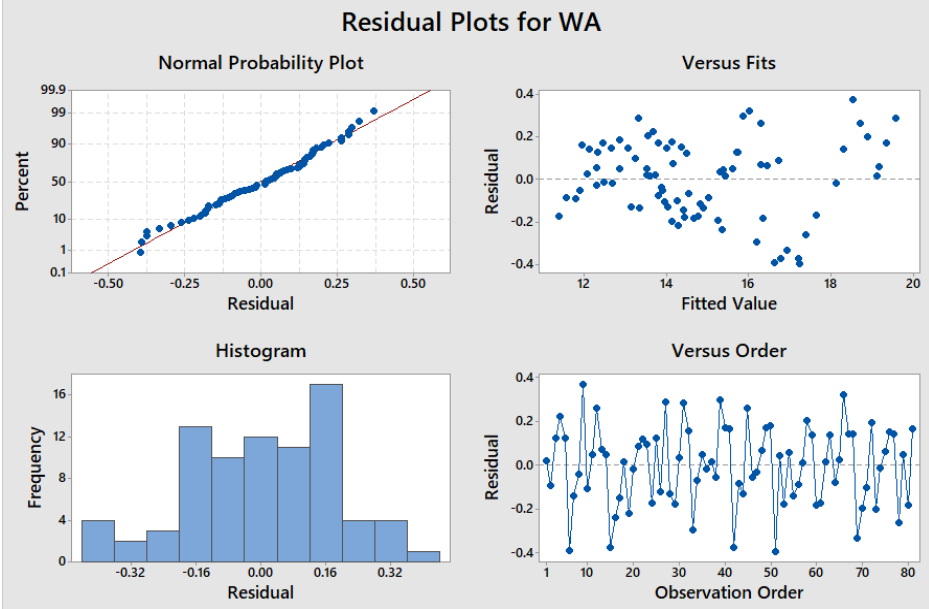
Figure 20. Residual plots of water absorption.